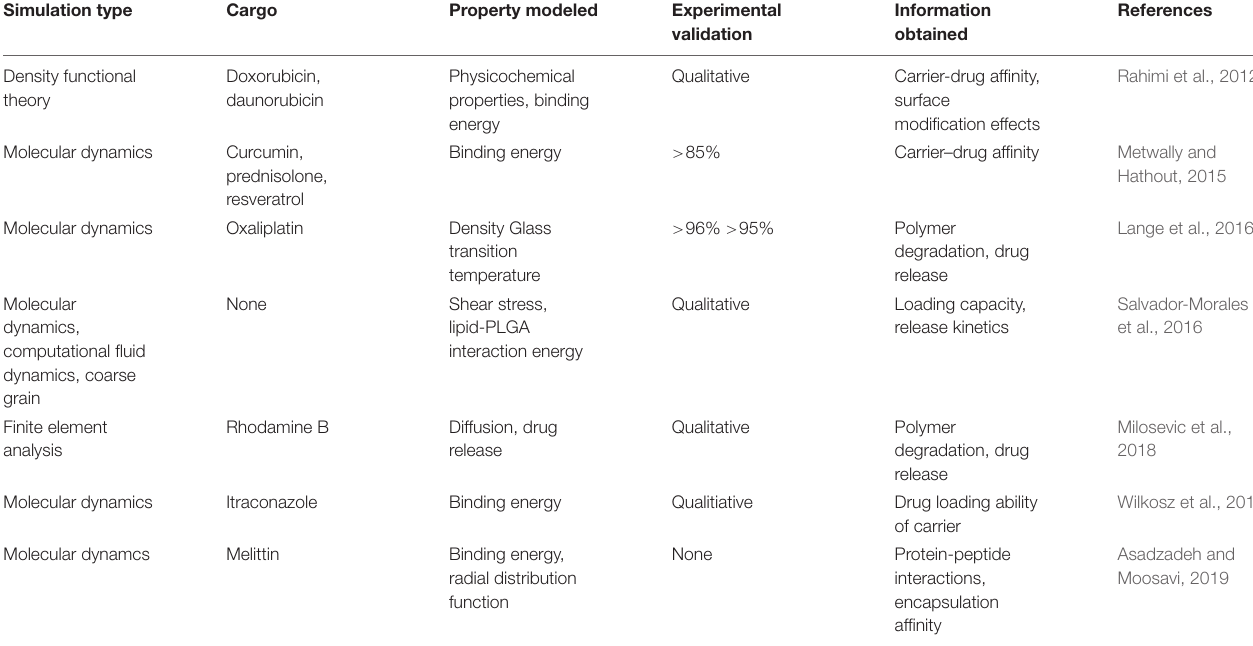
TABLE 2 | Molecular simulations of PLGA and their significance to nanocarrier drug delivery